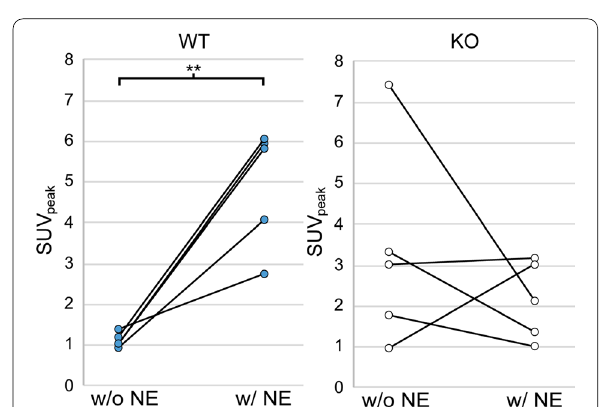
Fig. 8 Effect of NE injection on SUV peak for fasted male mice. SUV peak is plotted for each genotype with (w/NE) and without (w/o NE) NE injection. There is a significant increase in the SUV peak in the WT mice with NE injection ( p < 0.001). On the other hand, SUV peak in KO mice seems to either stay the same or decrease with NE injection. In addition, the average SUV peak in KO mice without NE stimulation is much higher than that in WT mice ( p =